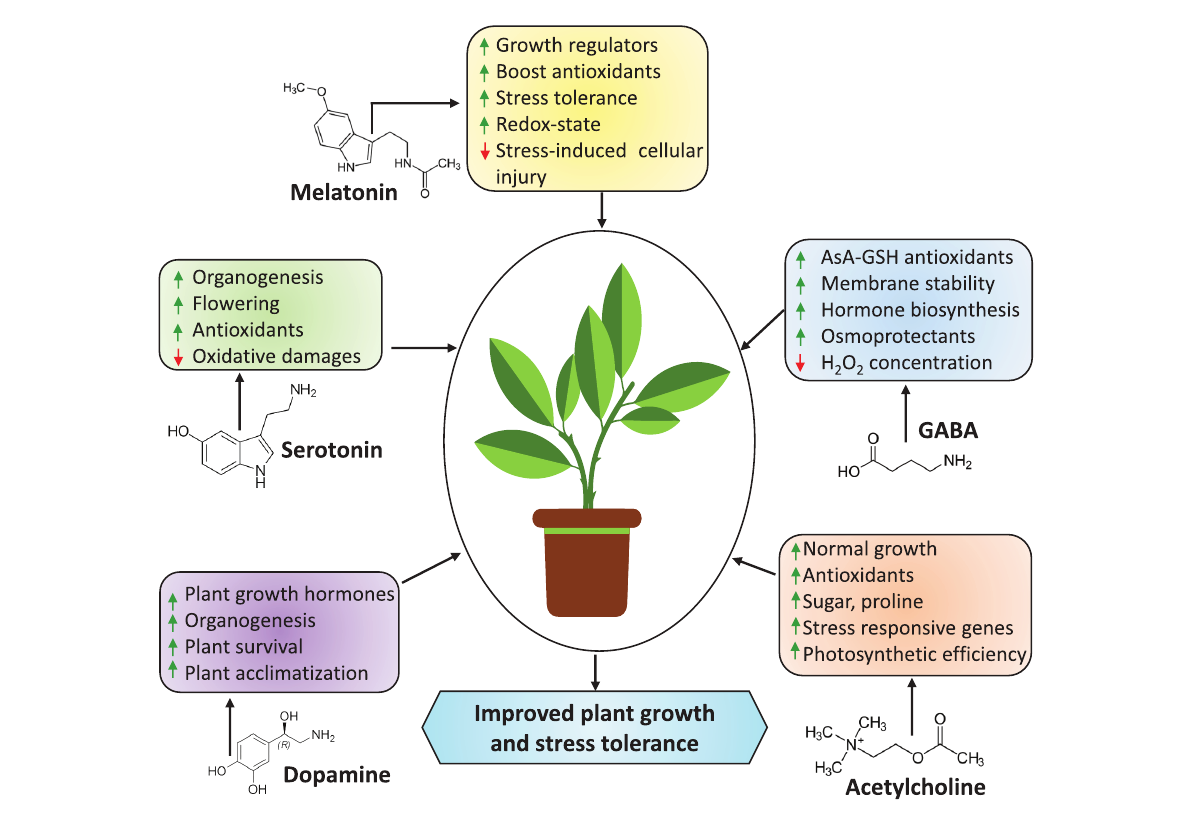
FIGURE7 Physiological role of neurotransmitters (NTs) associated with plant growth and stress tolerance in plants. NTs coordinate the regulation of plant growth, development, and adaptation/acclimatization, increasing plant stress tolerance. Up/down arrows indicate the increase/decrease of a physiological parameter. GABA, γ -aminobutyric acid; AsA-GSH, ascorbate-glutathione cycle.